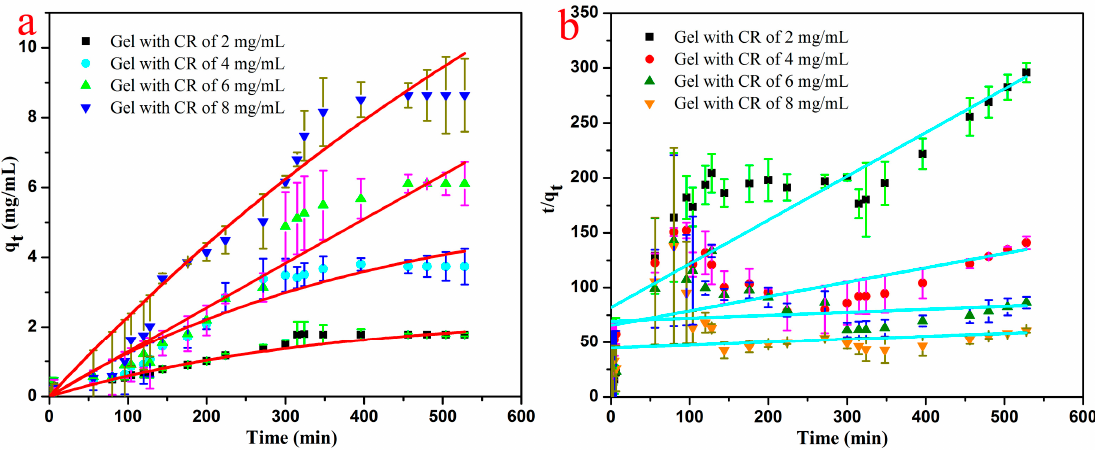
Figure 12. Release kinetics curves of as-prepared TC16-Fl organogels in n-pentanol with different CR concentrations at 298 K: ( a ) pseudo-first-order model; ( b ) pseudo-second-order model.